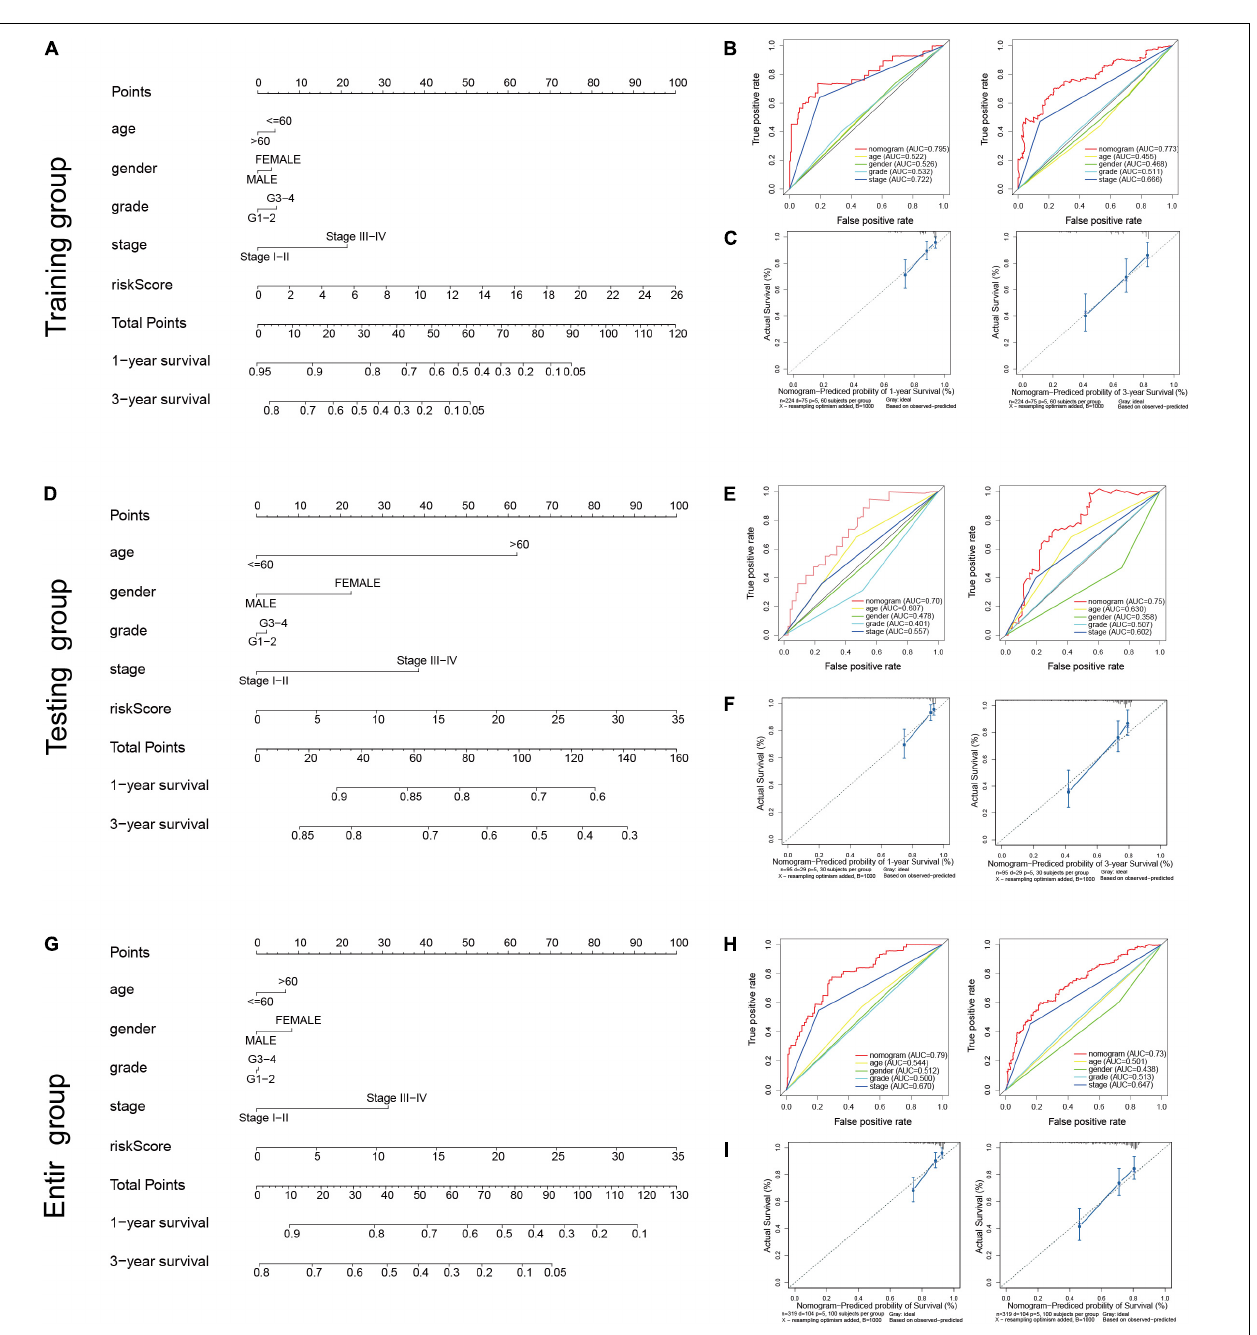
FIGURE 6 | Construction of the predictive nomogram for HCC patients. (A) Nomogram predicting the survival probability of 1- and 3-year OS in training group; (B) multi-indicator receiver operating characteristic (ROC) curves of the nomogram for 1- and 3-year OS in training group; (C) calibration curve of the nomogram for predicting 1- and 3-year OS in training group; (D) nomogram predicting the survival probability of 1- and 3-year OS in testing group; (E) multi-indicator receiver operating characteristic (ROC) curves of the nomogram for 1- and 3-year OS in testing group; (F) calibration curve of the nomogram for predicting 1- and 3-year OS in testing group; (G) nomogram predicting the survival probability of 1- and 3-year OS in entire group; (H) multi-indicator receiver operating characteristic (ROC) curves of the nomogram for 1- and 3-year OS in entire group; (I) calibration curve of the nomogram for predicting 1- and 3-year OS in entire group.